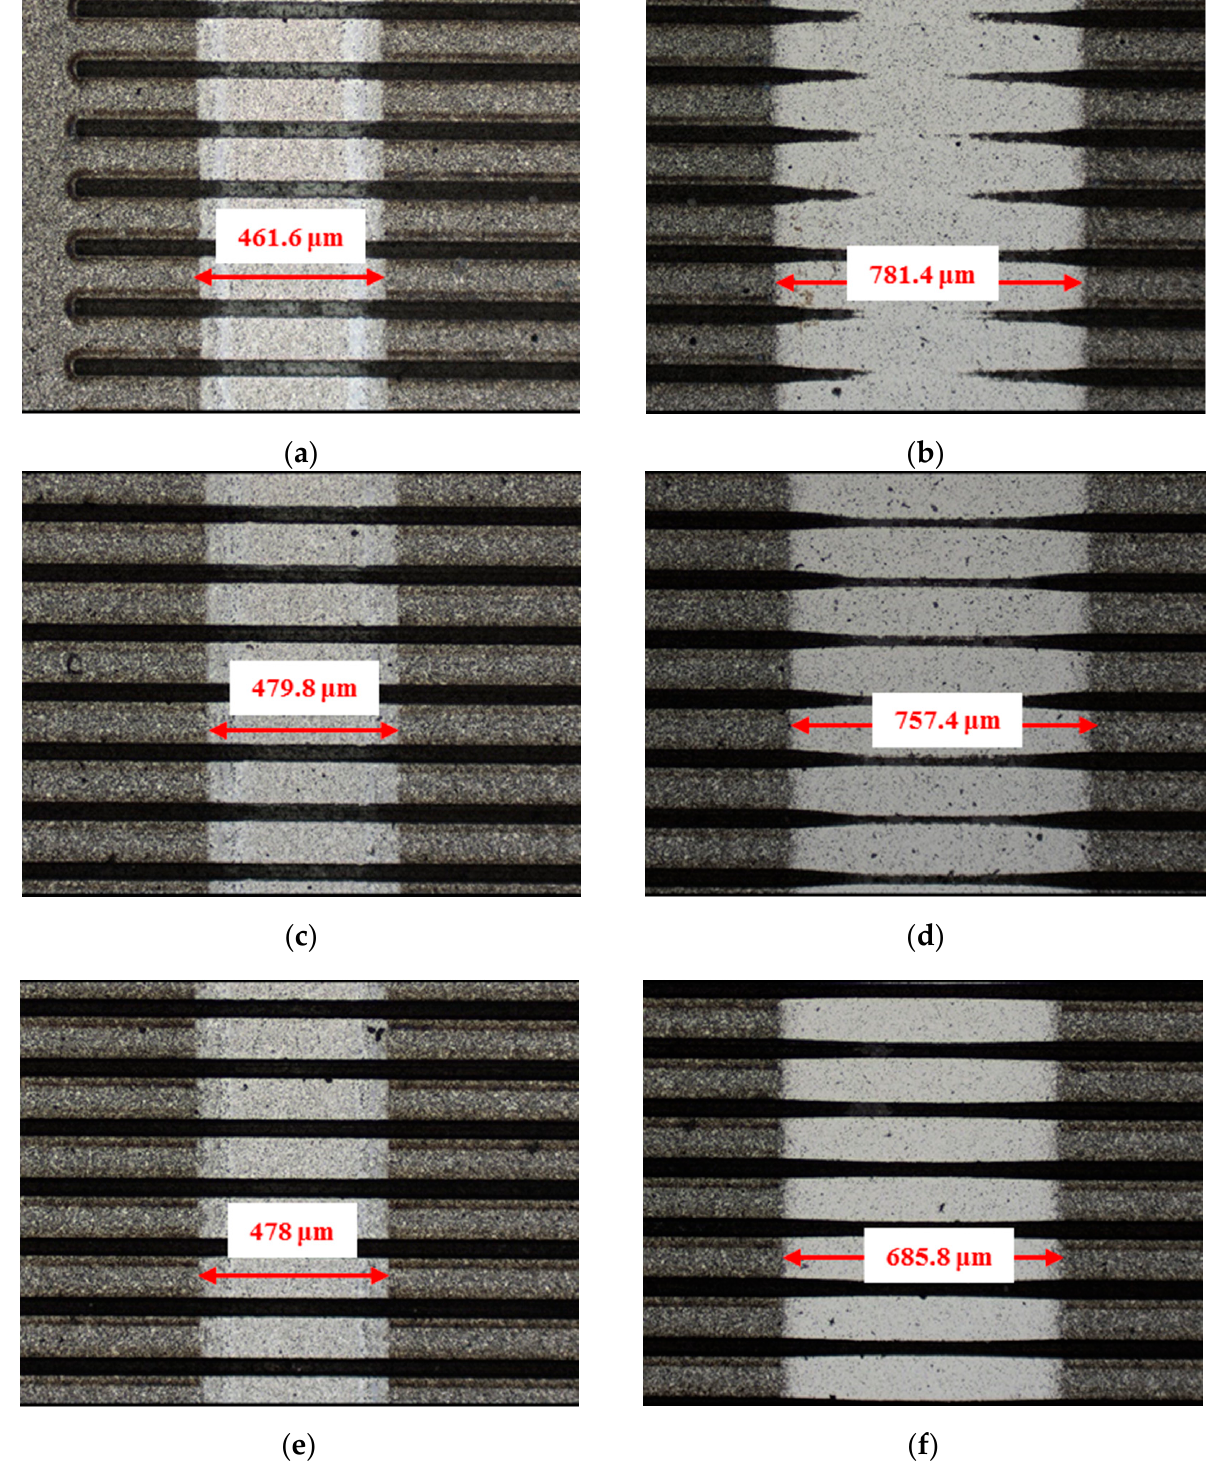
Figure 17. Wear performance of groove-textured SiC under water-lubricated conditions with a load of 75 N ( × 10): ( a ) 3 µ m groove-textured SiC-steel ball, ( b ) 3 µ m groove-textured SiC–Si 3 N 4 ball, ( c ) 5 µ m groove-textured SiC–steel ball, ( d ) 5 µ m groove-textured SiC–Si 3 N 4 ball, ( e ) 10 µ m groove-textured SiC–steel ball, and ( f ) 10 µ m groove-textured SiC–Si 3 N 4